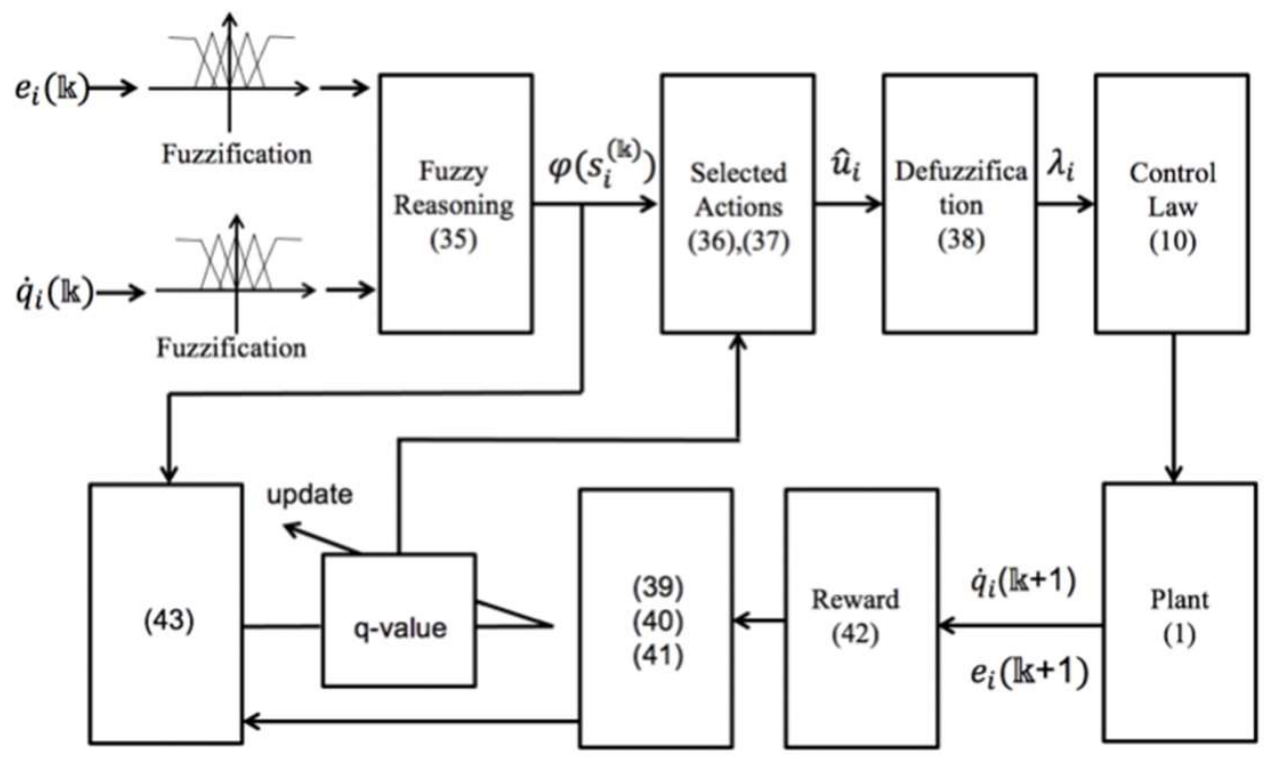
Figure 2. Membership function of fuzzy input of the 𝑖 (cid:3047)(cid:3035) subsystem. Figure 3. Flow chart of fuzzy Q learning to determine Λ i